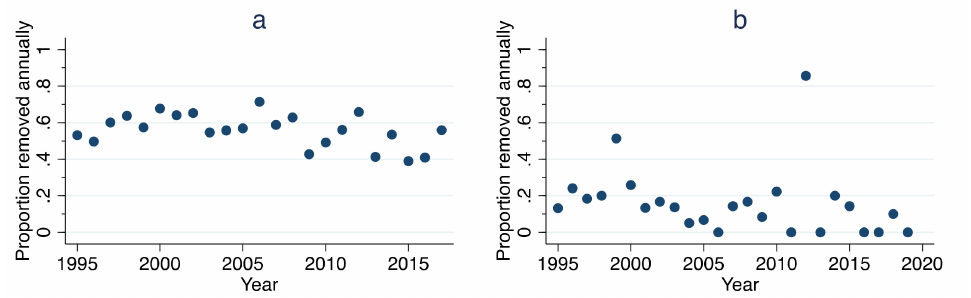
Figure 9. Proportion of cats removed annually for adoption, ORCAT program 1995–2016 ( a ) and UCF program 1995–2018 ( b